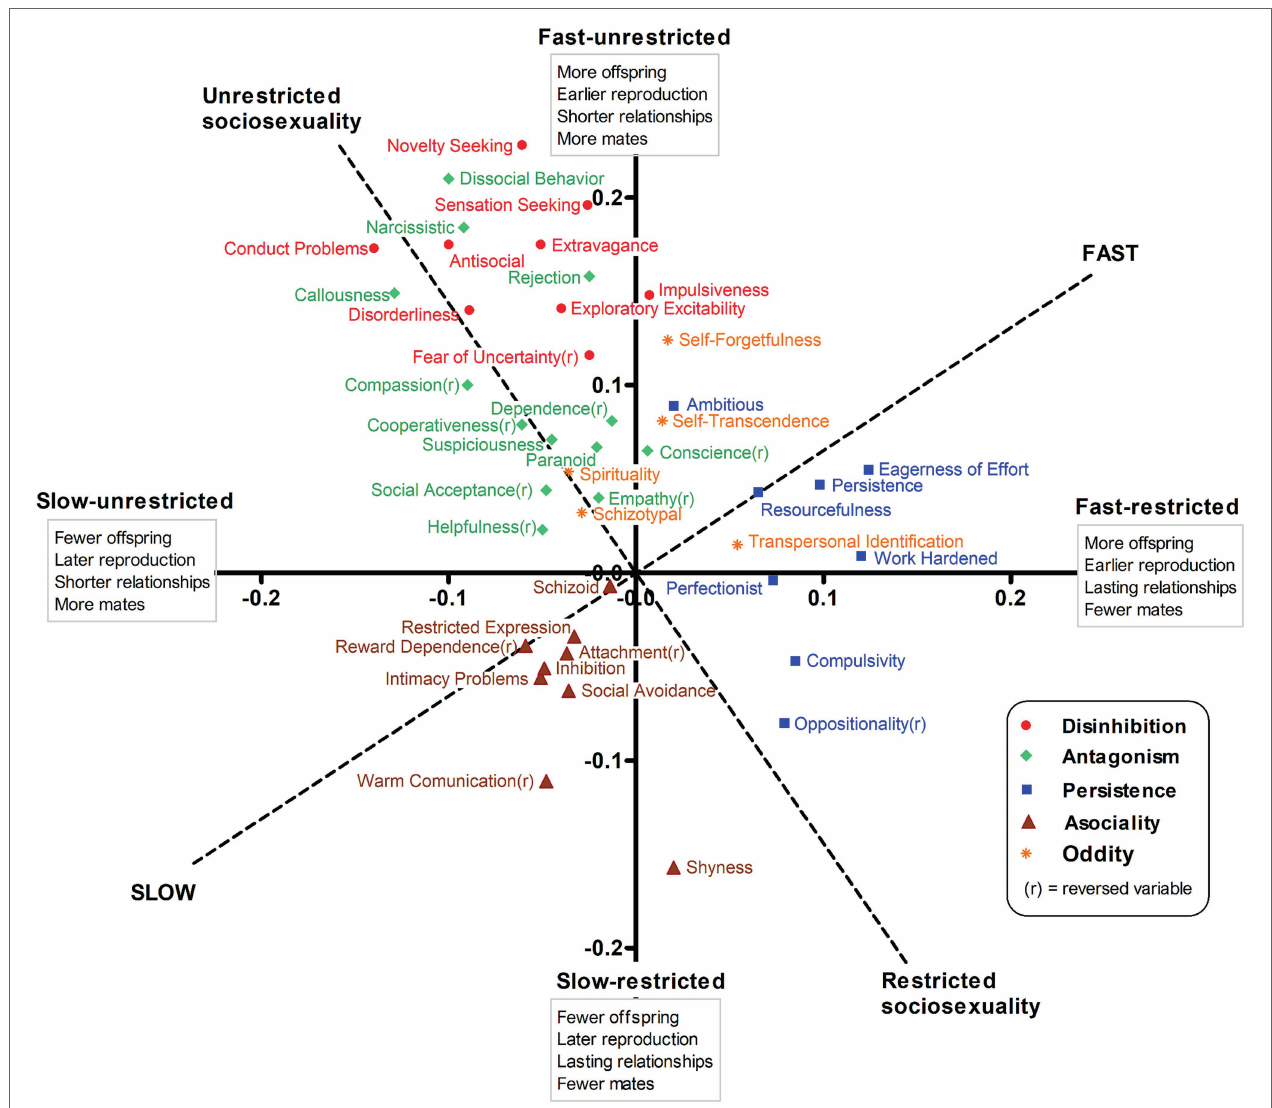
FIGURE 2 | Correlations of personality traits with unrotated and varimax-rotated axes for reproductive LH